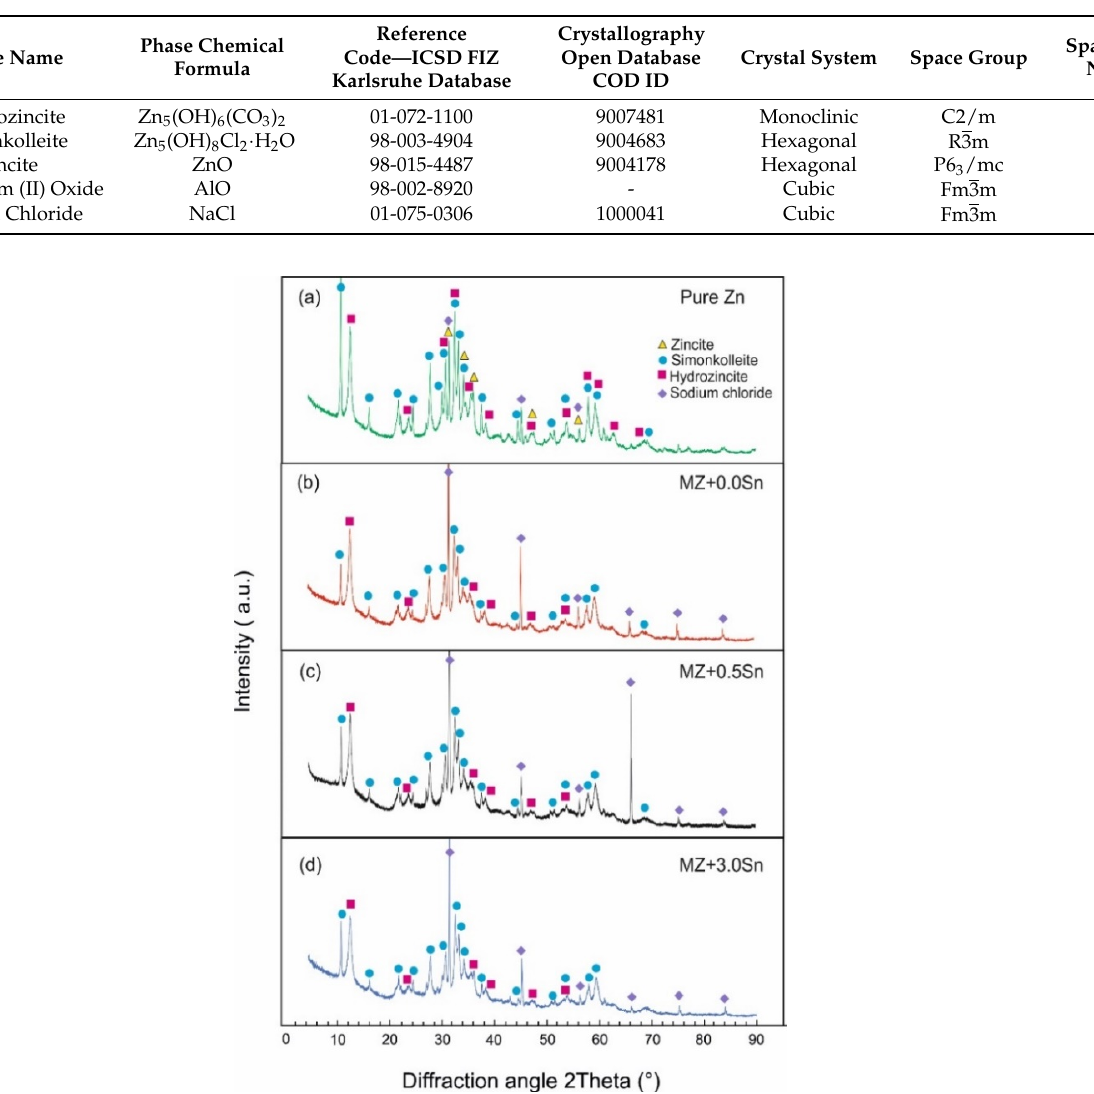
Table 4. Phases identified during XRD analysis.